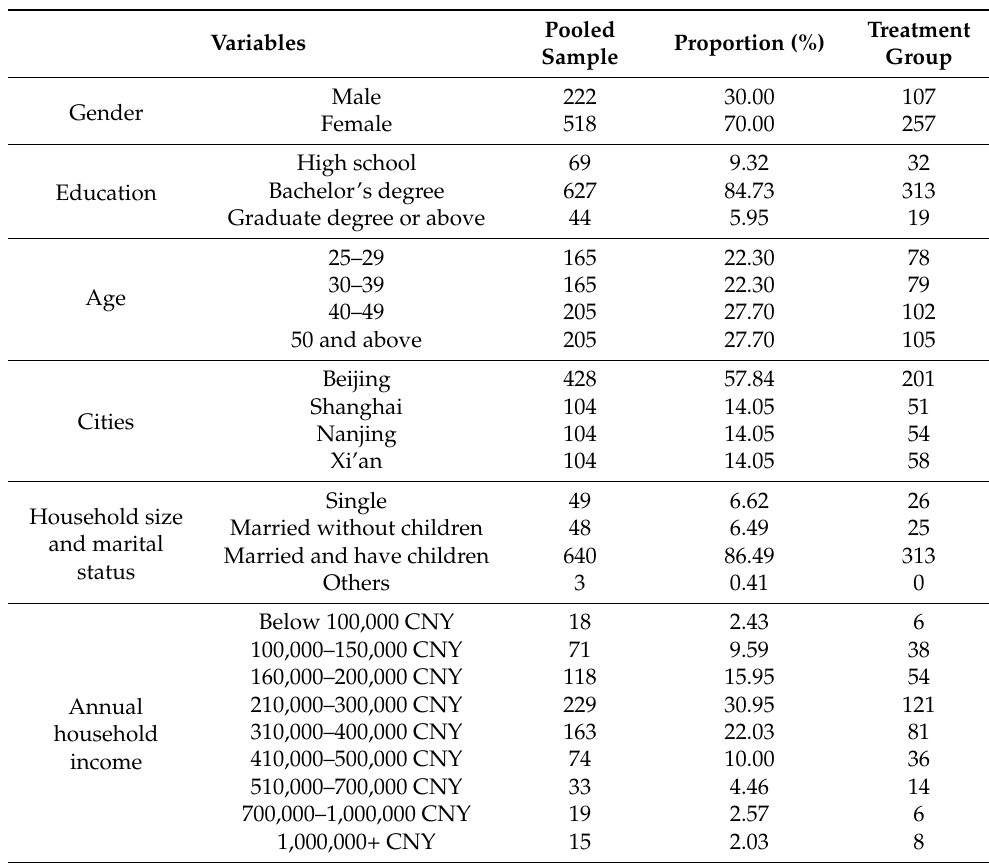
Table 2. Characteristics of survey sample.